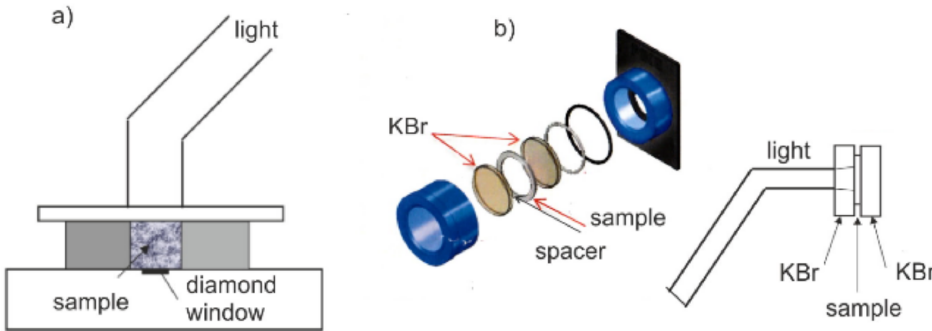
Figure 1. ( a ) Measurements with the ATR adapter, ( b ) Measurements in transmission mode. Before irradiating this surface of the sample with a light guide (8 mm in diameter), the FTIR spectrum was measured at different times. The diameter of the spot of light